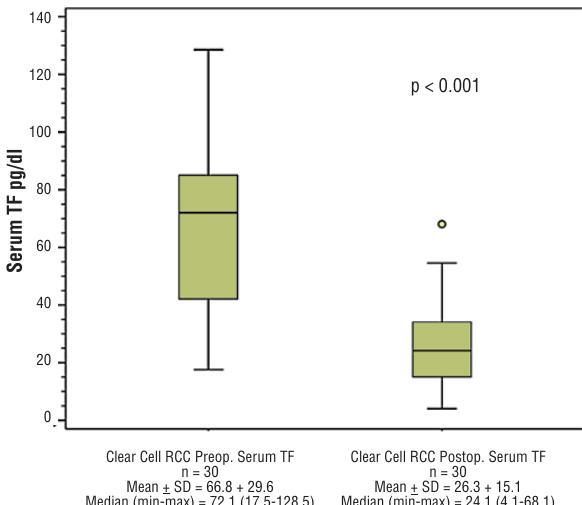
Figure 2 - Preoperativa and Postoperative serum TF. Figure 1 - serum TF in Controls and in Clear Cell